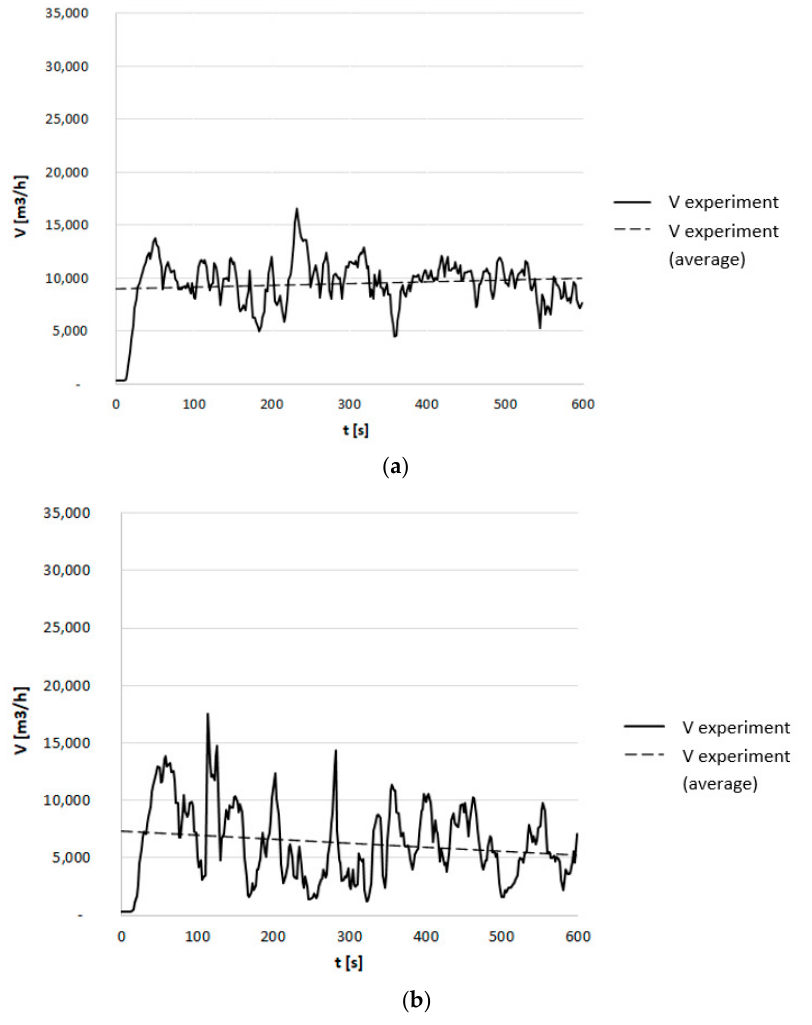
( c ) Figure 9. The air volume flowing through the smoke damper based on measurements for several values of outdoor temperature ( a ) − 2.0 °C, ( b ) 15.6 °C, and ( c ) 35.4 °C. 5. Numerical Model of the Analysed Geometry of the Staircase in the FDS Program 5.1. Grid Sensitivity Analysis After the initial preparation of the staircase model, the quality of the obtained results was verified in the simulation program, taking into account the number of calculation cells and the calculation time. For the comparative analysis of the obtained results, the temperature distribution in the staircase space was taken into account. The list of the adopted cell sizes, calculation time, and the obtained results are presented in Table 1 for the 15th and 60th seconds of the simulation.